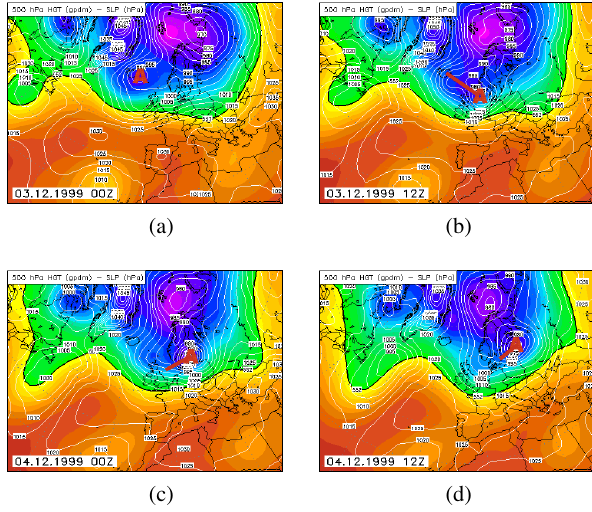
subfigures (c) and (d).